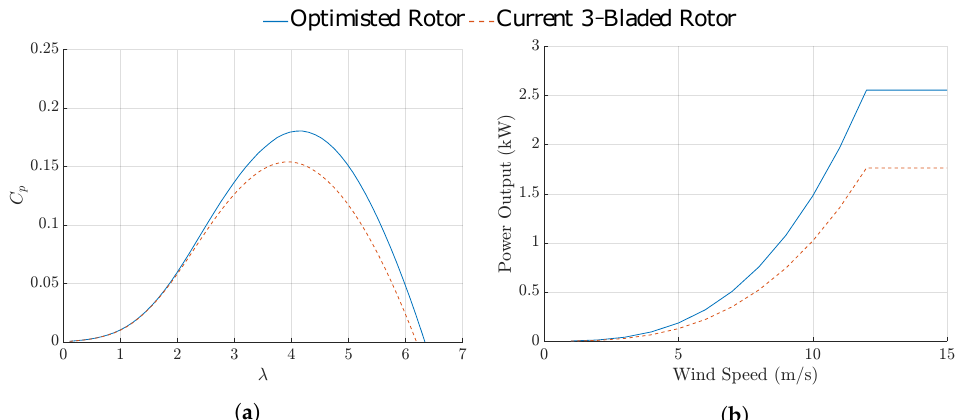
Figure 27. Optimised rotor design compared to the rotor used in prototype configuration 8. ( a ) C p vs. λ ; ( b ) Power output.